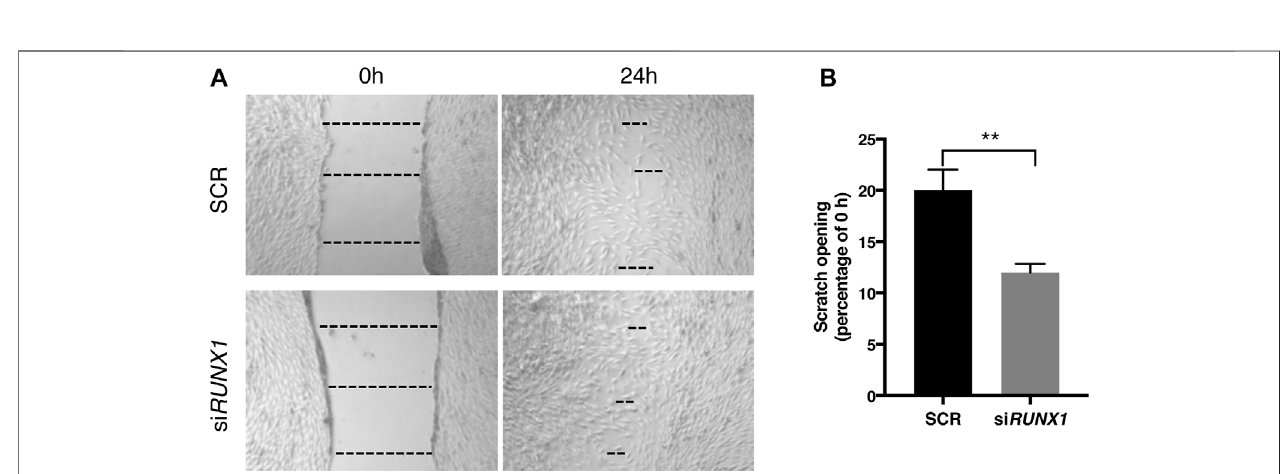
FIGURE8| RUNX1 silencingin fl uencestrisomiccellmigrationproperties.Therateofmigrationwasmeasuredbyquantifying,indifferentpoints,thedistanceofthe area lacking cells. (A) Representative images of scratch opening of SCR and si RUNX1 -treated DS-HFF at 0 and 24 h. The dotted lines de fi ne the area lacking cells (wound area, ImageJ). (B) Scratch opening quanti fi cation. Mean values ± SEM from four SCR- and four si RUNX1 -treated trisomic samples are represented as percentage of scratch opening at 0 h. ** p -value ≤ 0.01.